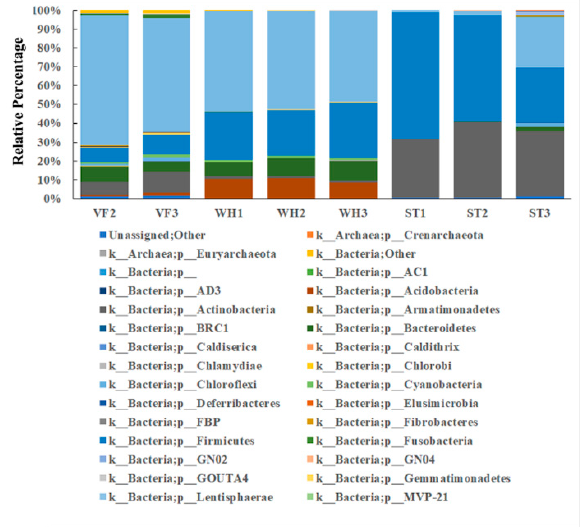
Figure 5. Relative abundance of the microbial communities in VF, WH, and ST, revealed by the 16S rRNA gene at the phylum level. The relative abundance is defined as a percentage of the total microbial sequences in a sample.